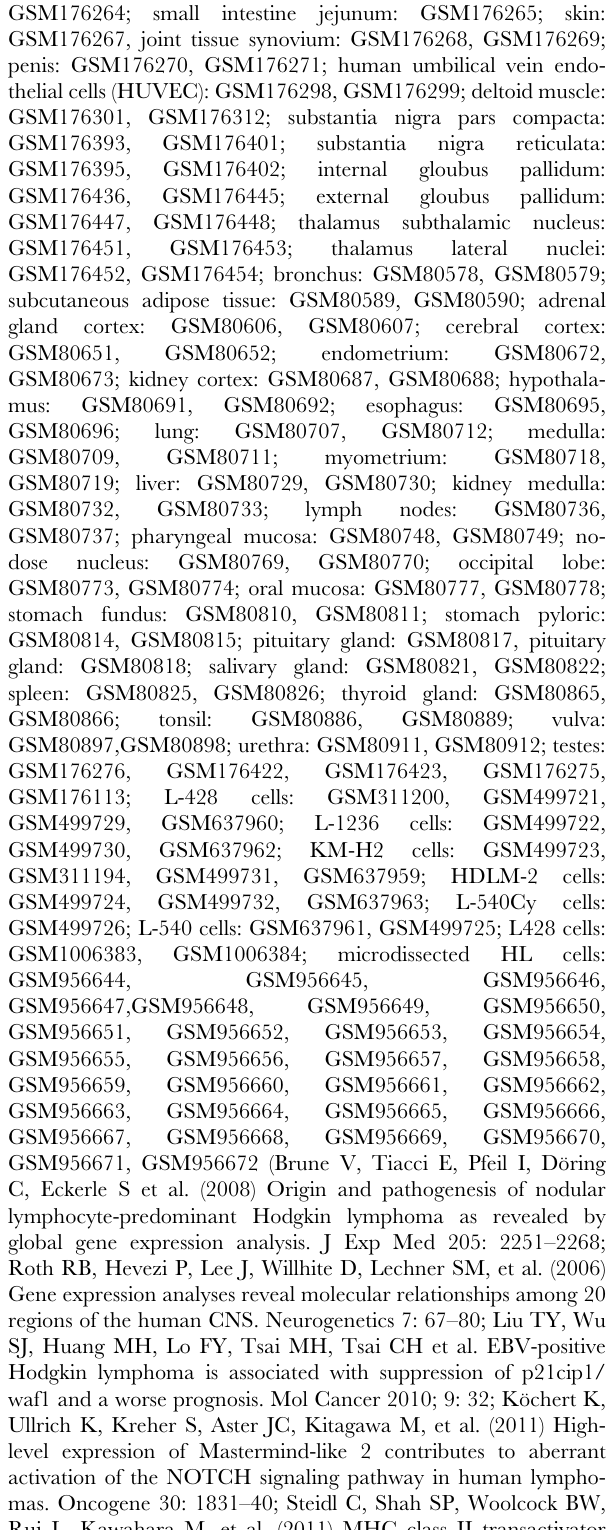
DUSP5 DNA were indicated by black squares and were not to scale. The lengths of these introns as well as the start position of the 4 exons from DUSP5 are indicated. The pseudogene from chromosome 3 contains additional insertions which are indicated by red triangles. Color code: red: A; green: C; yellow: G; blue: T. Data visualization was performed with GeneDoc (http://www.psc. edu/biomed/genedoc). Figure S5 Sequence alignment of the predicted DUSP5P1 peptide and DUSP5 proteins from varying Mammalia. Presented is an alignment between the putative DUSP5P1 peptide and the homologous region from (predicted) DUSP5 proteins from Oryctolagus anatinus, Monodelphis domes- ticus, Myotis lucifugus, Bos Taurus, Rattus norvegicus, Canis lupus familiaris, Papio anubis, and Homo sapiens. DUSP5 loci in the genomes of all species were identified essentially as described (Hesse M, Willscher E, Schmiedel BJ, Posch S, Golbik RP, Staege MS (2012) Sequence and expression of the chicken membrane- associated phospholipases A1 alpha (LIPH) and beta (LIPI).